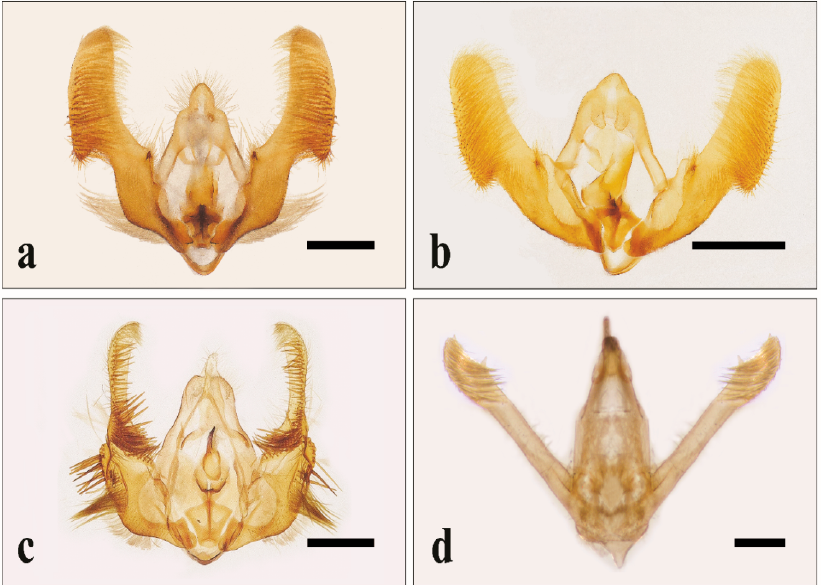
Figure 2. Male genitalia of: Epiblema foenella (L.) ( a ); E . scutulana (Denis & Schiffermüller) ( b ); Celypha striana (Denis & Schiffermüller) ( c ); Idaea rusticata (Denis & Schiffermüller) ( d ). Bar: 500 μ m.